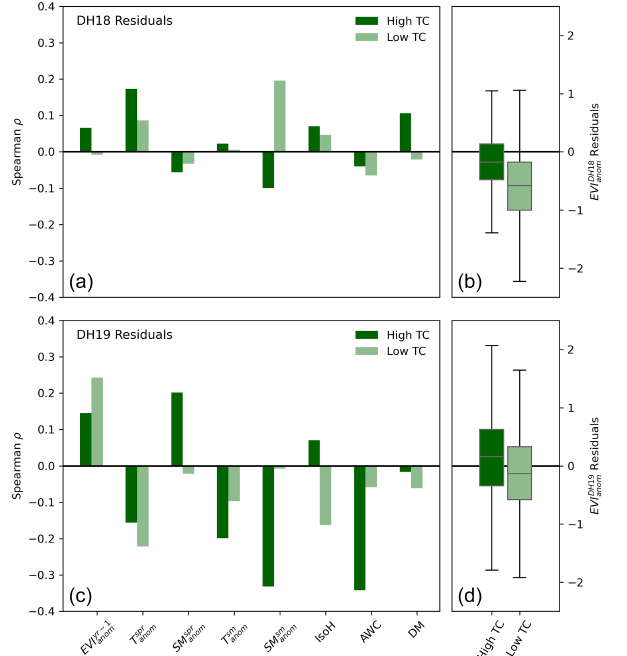
Figure 6. Spatial partial correlation (Spearman) between EVI anom residuals and environmental variables in DH18 (a, b) and DH19 (c, d) for pixels with high (dark green, top 5% tree cover fraction) and low (light green, lowest 5% tree cover fraction) tree cover (a, c) . High tree cover (TC) pixels have tree cover fractions above 58% and low TC pixels have virtually no trees (TC < 0 . 4%). The vari- ables considered are spring and summer T anom and SM anom (indi- cated by superscripts “spr” and “sm”, respectively), EVI anom in the previous growing season (EVI yr − 1 ), plant isohydricity (IsoH), and the number of dry months (DM). Because of the large number of pixels considered, all correlations are significant ( p − val (cid:28) 0 . 01). Panels (b) and (d) show the distribution of residuals for pixels with high and low tree